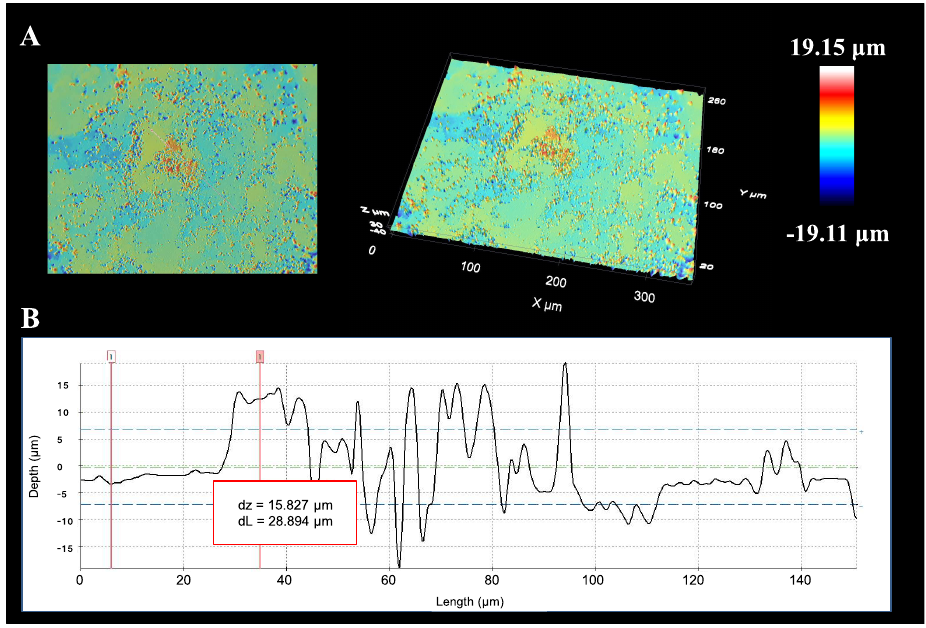
Figure 3. Transmission electron microscopy images of SWNHs at low ( A ) and high ( B ) magnification. The confocal profile image of the SWNH-monolith is shown in Figure 4. 2D and 3D representations of their surface topographies with a color scale for the z-range calibrated in micrometers (µm) are illustrated. It is possible to distinguish the surface roughness of the macroscopic SWNH-monolithic solid as well as the depth profile along a vertical line with a mean of the absolute values of the profile heights measured from a mean line averaged over the profile (Ra) of 3.685 µm.